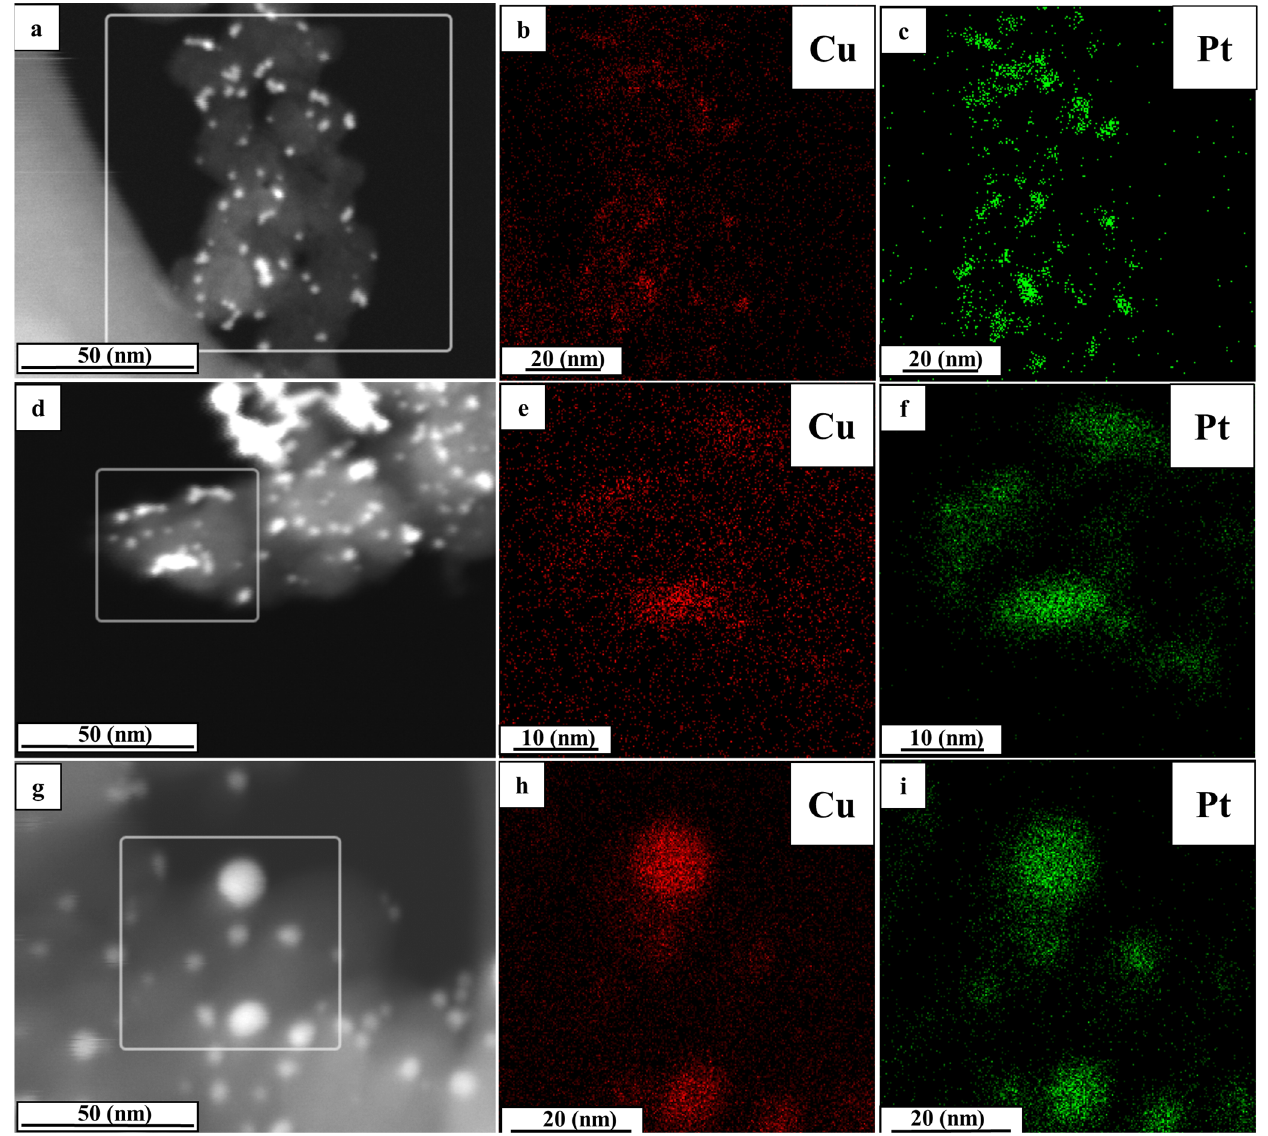
Figure 3. The elemental mapping of the AC ( a – c ), AC_acid ( d – f ), and AC_350 ( g – i ) samples.